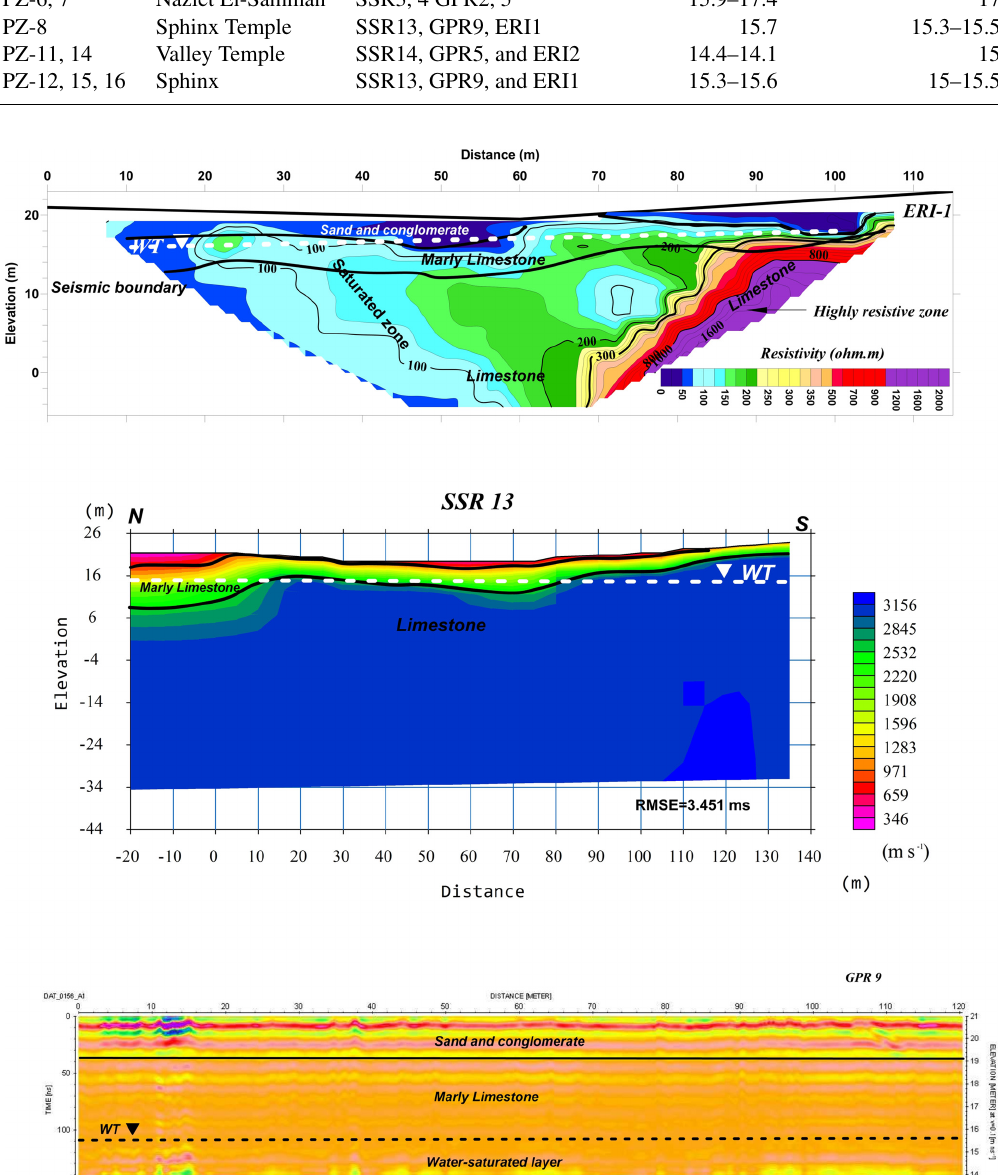
Figure 6. ERI, SSR, and GPR profiles for the Sphinx and the Sphinx Temple.